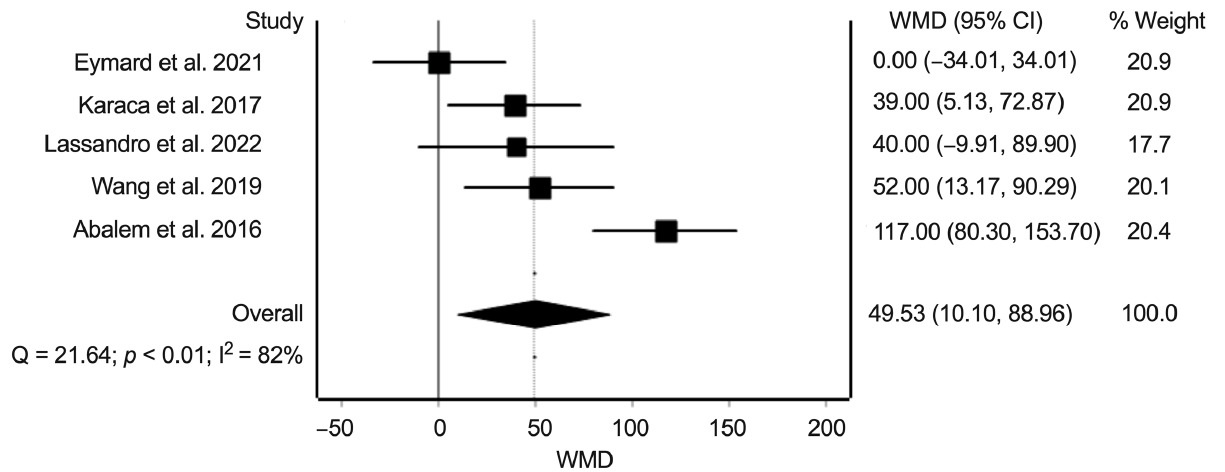
Figure 2. Meta-analysis of the weighted mean difference (WMD) in µm in the subfoveal choroidal thickness between eyes of patients with Cushing’s syndrome and eyes of matched healthy controls. Heterogeneity statistics (Cochran’s Q = 21.6; p < 0.01; I 2 = 82%) show substantial heterogeneity across individual studies [15,17–20].